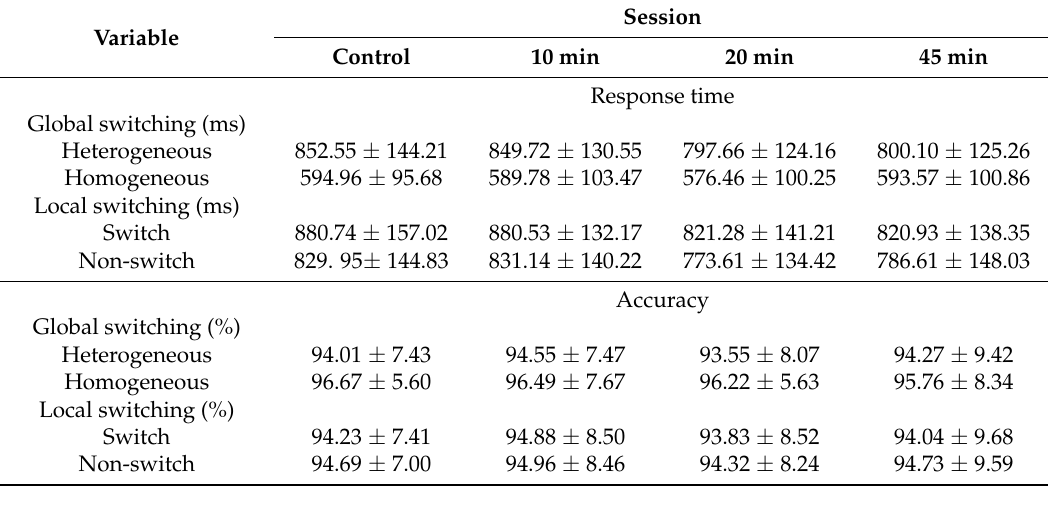
Table 2. Response time and accuracy for global switching and local switching across four sessions (mean ± SD).